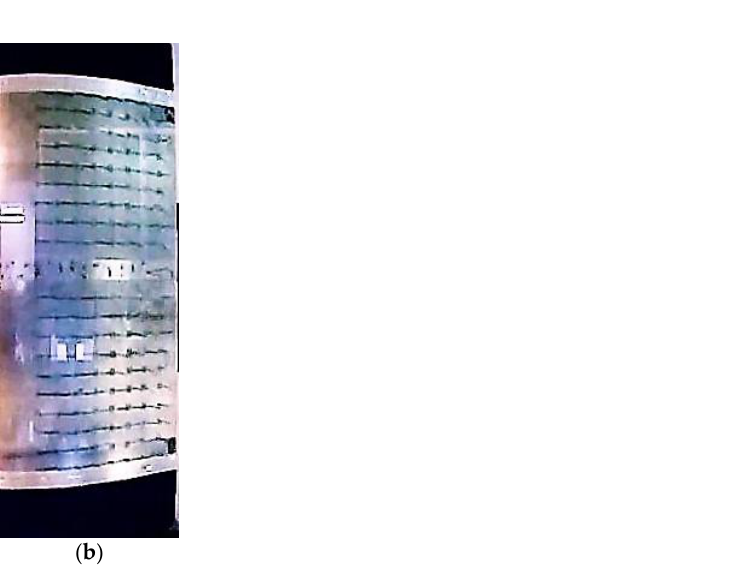
Figure 17. Tuft flow visualization: 15° ± 8°: ( a ) 16.0° upstroke, k = 0.1, ( b ) 16.1° upstroke, k = 0.2.